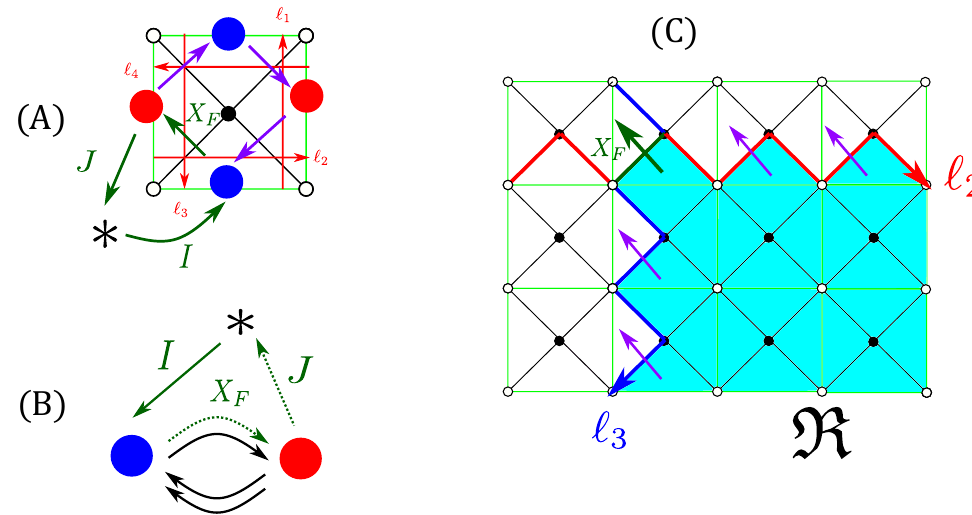
Figure 13. Two-dimensional crystal of the conifold with a D4-brane wrapping the divisor D = (1 , 0) . (A) Brane tiling of the setup. (B) Quiver of the setup. The dashed arrows J, X are zero in the F supersymmetric vacua, and thus, the quiver is understood as a subquiver of the D6-D2-D0 case. (C) Region of the two-dimensional crystal in the universal covering. The light blue region R is surrounded by the external legs ‘ . The green and purple arrows are outgoing 2 , ‘ 3